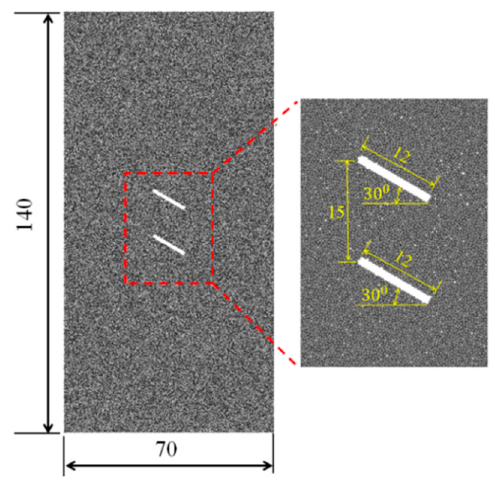
Figure 1. Numerical model for pre-existing parallel flaws layout ( α = 30 ◦ , Unit: mm).